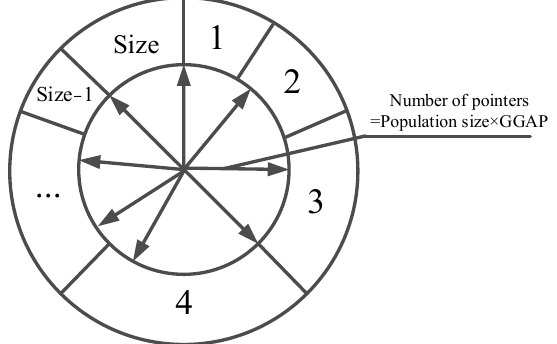
Figure 5. All over roulette wheel selection